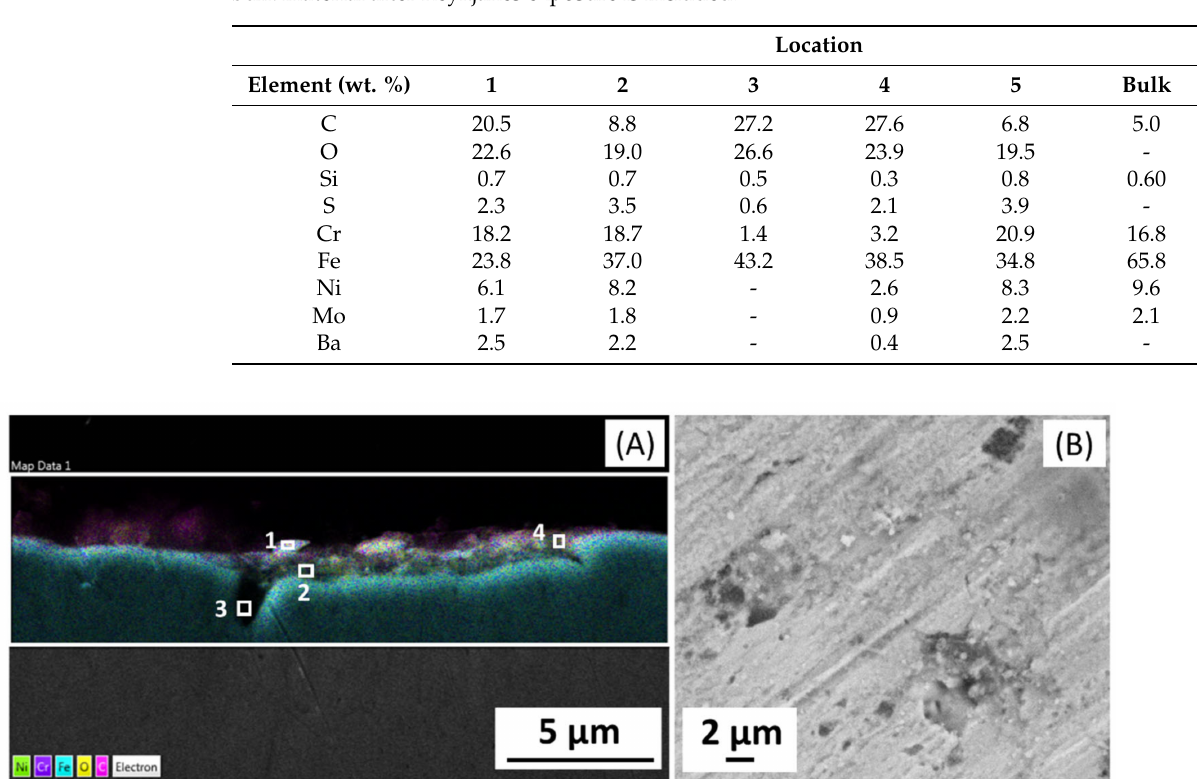
Figure 9. Elemental analysis and mapping of 316L after being exposed in the pressure vessel at Reykjanes at 200 ◦ C, showing locations where Energy-Dispersive X-ray spectroscopy (EDX) elemental analysis was performed. There are two semi-homogenous layers over all the cross-sections analysed. The layer in locations 1, 2 and 5 is an inner corrosion layer while the top layer, locations 3 and 4, is an outer corrosion layer mostly composed of Fe and O. The colour map shows the relative composition of Cr, S, Fe, O and C in the material. Table 5. EDX elemental analysis of locations shown in Figure 9. For comparison, an analysis of the bulk material after Reykjanes exposure is included.